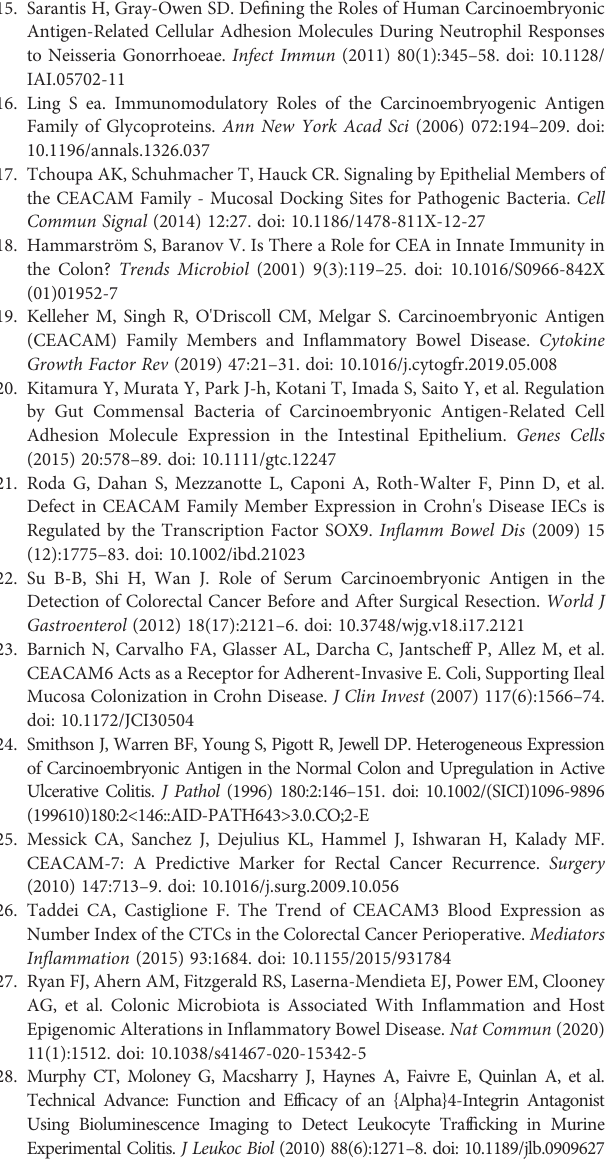
Supplementary Figure 1 | (A) Representative side scatter plot versus live/dead staining. Numbers in the quadrant represent the live cells. (B) Representative live/ dead versus anti-CEACAM1, anti-CEACAM3, anti-CEAM5 (as indicated) dot plots of epithelial cells (C2BBe1), after gating on live cells. Numbers in quadrants indicate percentage of respective quadrant